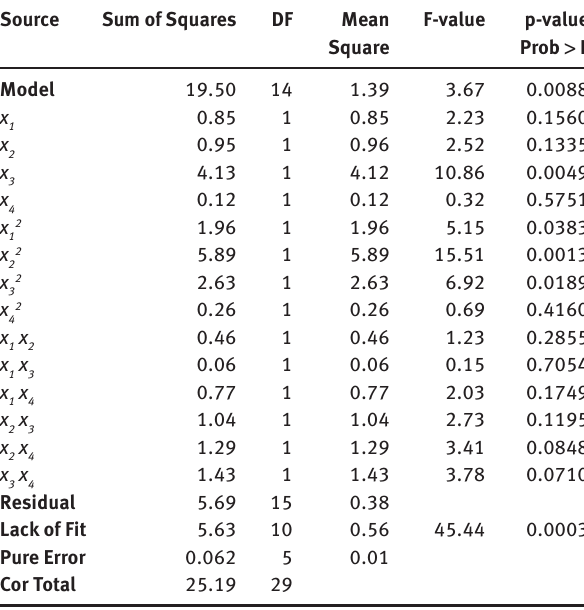
Table 3: ANOVA for quadratic model. Source Sum of